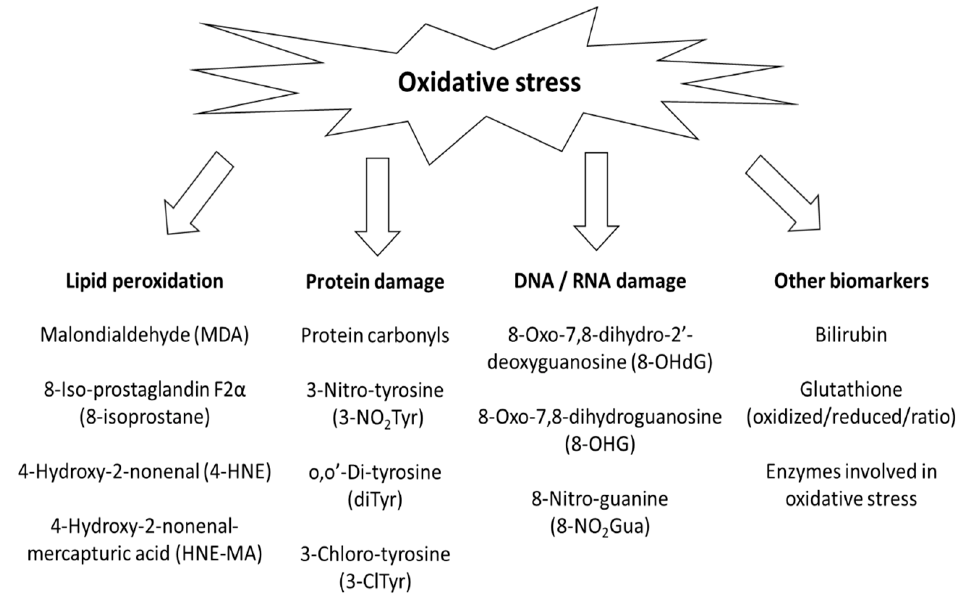
Figure 1. Commonly measured biomarkers of oxidative stress after BPA exposure in humans.